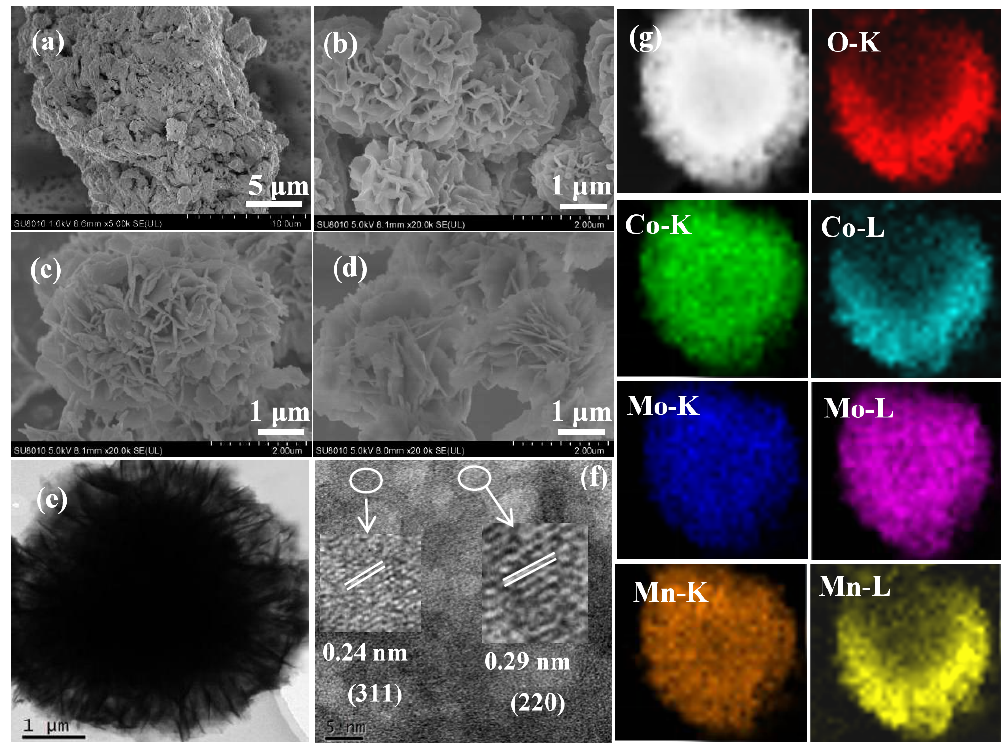
Figure 2. Scanning electron microscope (SEM) images of the ( a ) MoO 3 -doped MnCo 2 O 4 (0), ( b ) MoO 3 -doped MnCo 2 O 4 (0.04), ( c ) MoO 3 -doped MnCo 2 O 4 (0.10), ( d ) MoO 3 -doped MnCo 2 O 4 (0.12). ( e ) TEM image, ( f ) HRTEM image, and ( g ) elemental mapping images of the MoO 3 -doped MnCo 2 O 4 (0.10).